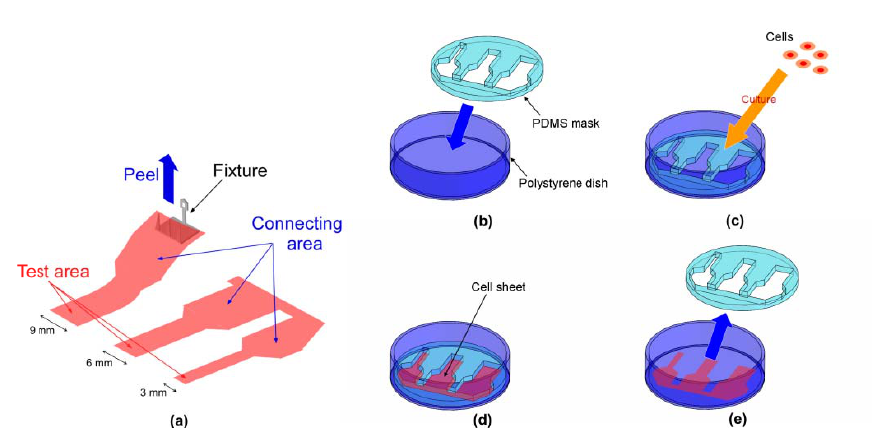
Fig. 4 S Schematic diagram of the formed cell sheet. (a) The cell sheet was d area. Th he peel test was performed in the test area. The test area was separa 6 mm and 9 mm, respectively. The connecting area connected the c ell sheet formation process. First, (b) the PDMS mask was adhered ultured in PDMS mask. Finally, (e) the PDMS mask was removed otten which formed the requisite shape.